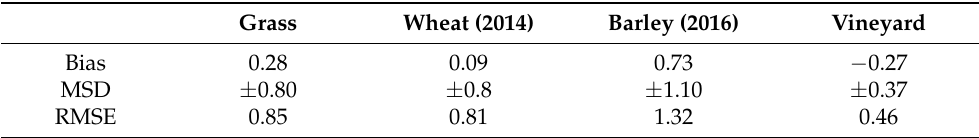
Table 4. Statistical analyses of the S-SEBI model performance with daily (mm/day) lysimetric data, excluding partial cloudy days ( n =